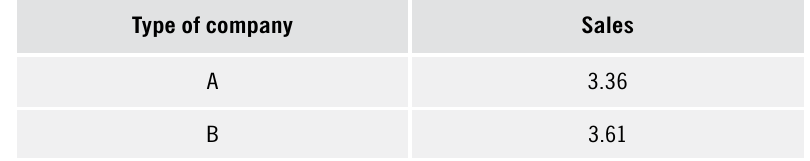
Table 6. Level of sales of A- and B-type companies compared to closest competitors Type of company Sales A 3.36 B 3.61